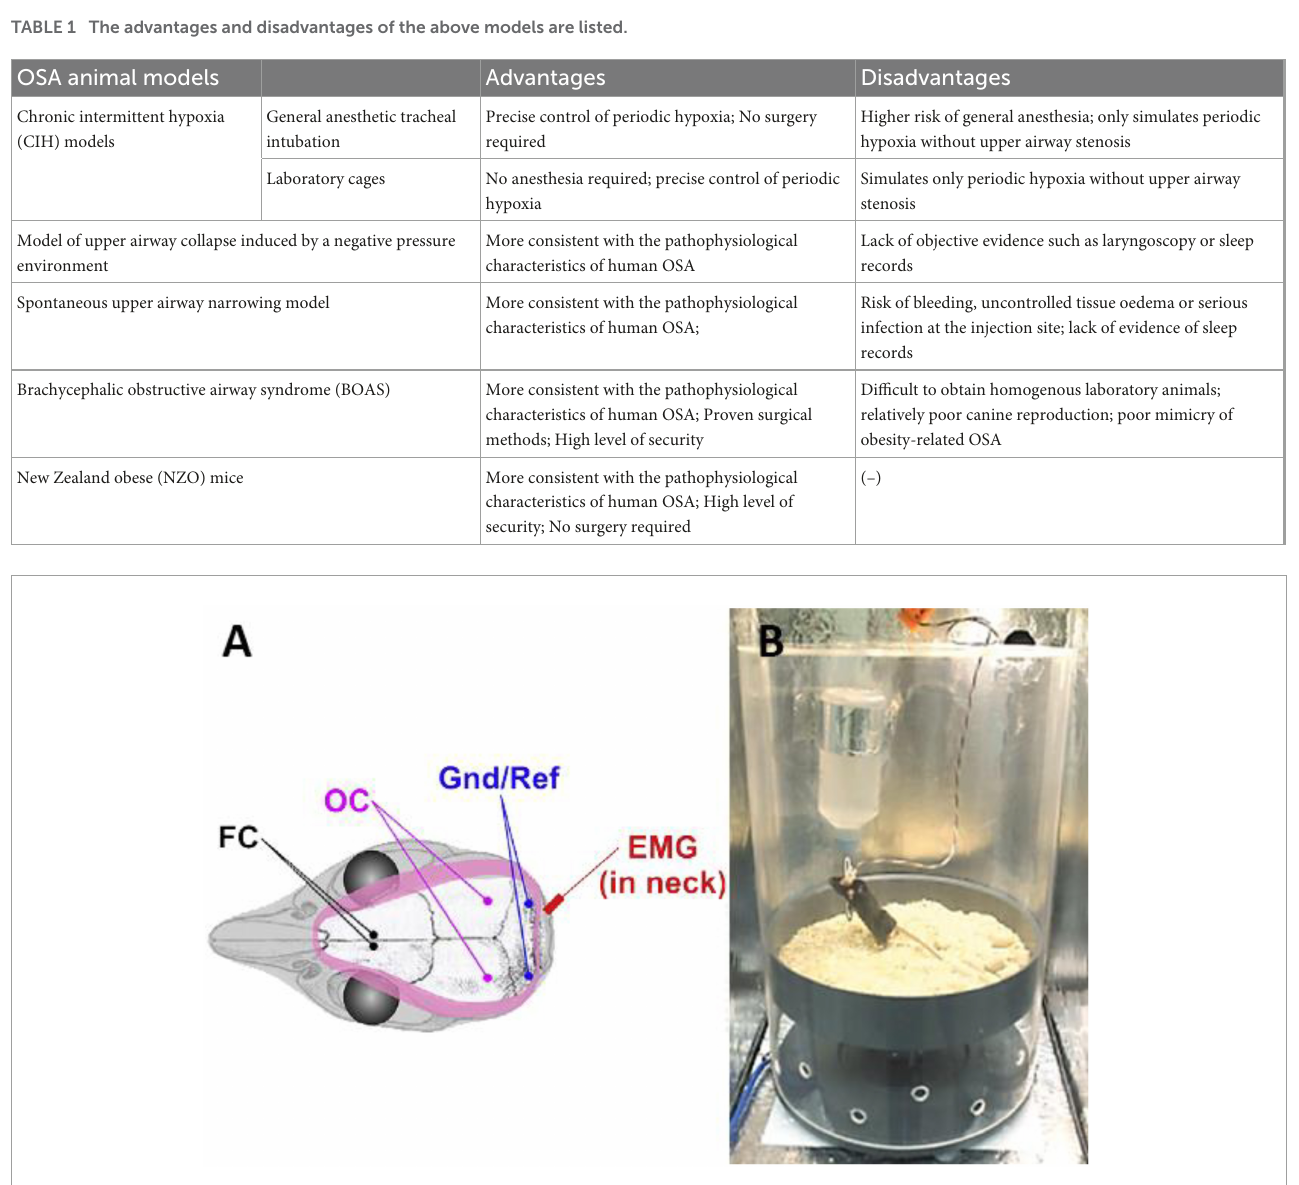
FIGURE2 Schematic diagram of EEG/EMG electrode placement during PSG implementation in rodents (A) and the relationship between animals, wires and cages during data recording (B) (45, 46). FC, frontal cortex; OC, occipital cortex; Gnd/Ref, grounding/reference electrode; EMG,